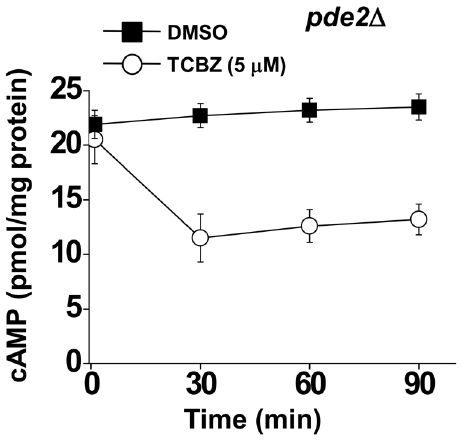
Figure 8. Triclabendazole decreases cAMP in pde2 D cells. Intracellular level of cAMP in pde2 D cells. Cells ( pde2 D ) were inoculated in SC-glucose medium and grown to mid-log phase, drug was added, and the samples were incubated for the indicated times. cAMP was extracted from cells and quantified using an immunoassay (Cell Signaling). Values are the mean 6 SD of the four independent experiments.